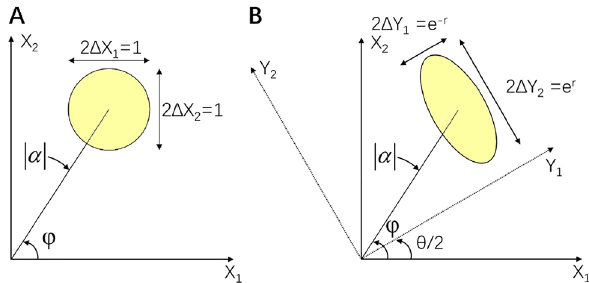
Figure 23: (A) An error circle of coherent state | 𝛼 ⟩ in the complex-amplitude plane. (B) An error ellipse of squeezed state | 𝛼,𝜁 ⟩ in the complex-amplitude plane. The yellow parts of both figures are the error area.